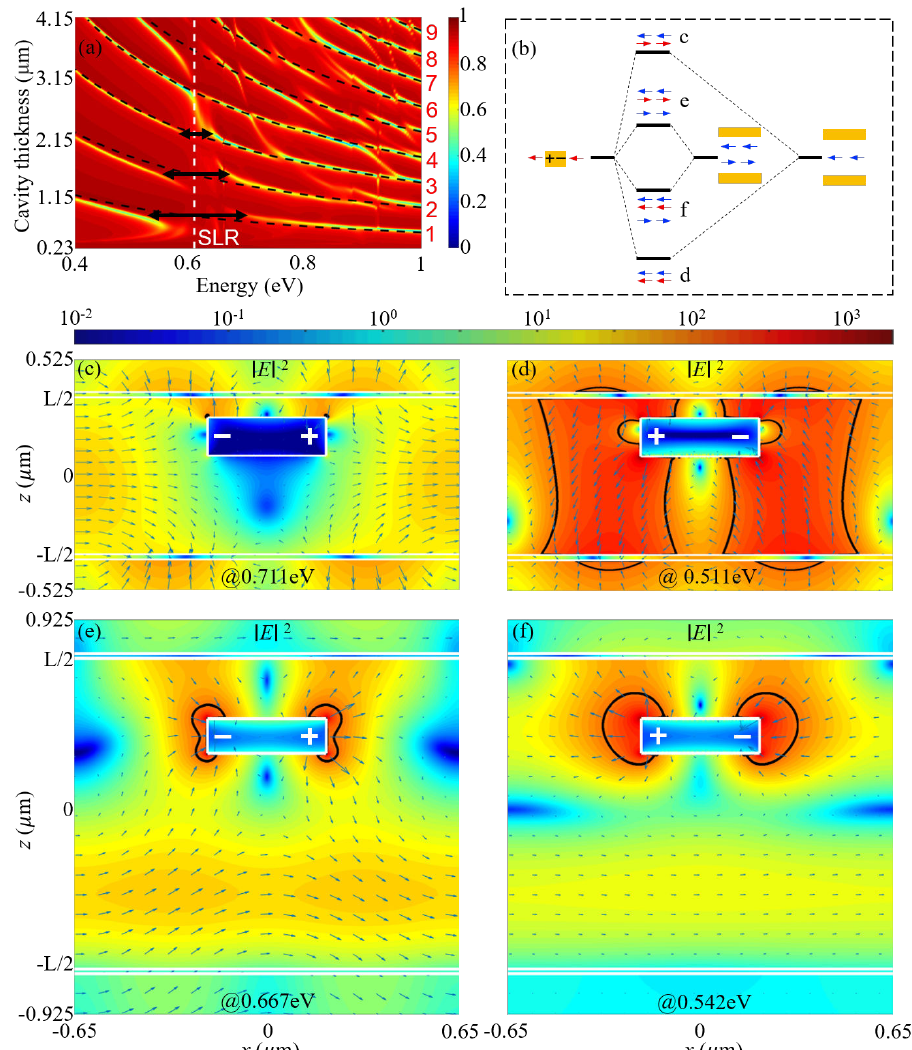
Figure 6. Strong coupling between the SLR and the F-P resonance when the gold nanorod array is positioned with distances to the top and bottom gold mirrors with a ratio of 1:3. ( a ) Simulated reflectance spectra for different cavity lengths. The F-P resonances are indicated by black dashed curves, and the SLR wavelength is indicated by the vertical white dashed line. ( b ) Schematic illustration of the strong coupling of the first- and second-order F-P resonances and the SLR into bonding and antibonding split modes. ( c – f ) Simulated electric field distributions | E | 2 of the split modes at ( c ) 0.711 eV ( d ) 0.511 eV due to the strong coupling between the SLR and the first-order F-P resonance with L = 765 nm, and at ( e ) 0.667 eV and ( f ) 0.542 eV due to the strong coupling between the SLR and the second-order F-P resonance with L = 1490 nm. The nanorods array and the thin metal films are outlined by white lines. “+” and “ − ” in ( d – f ) indicate charge distributions. The black curves in ( d – f ) show contours for electric field intensity enhancement of